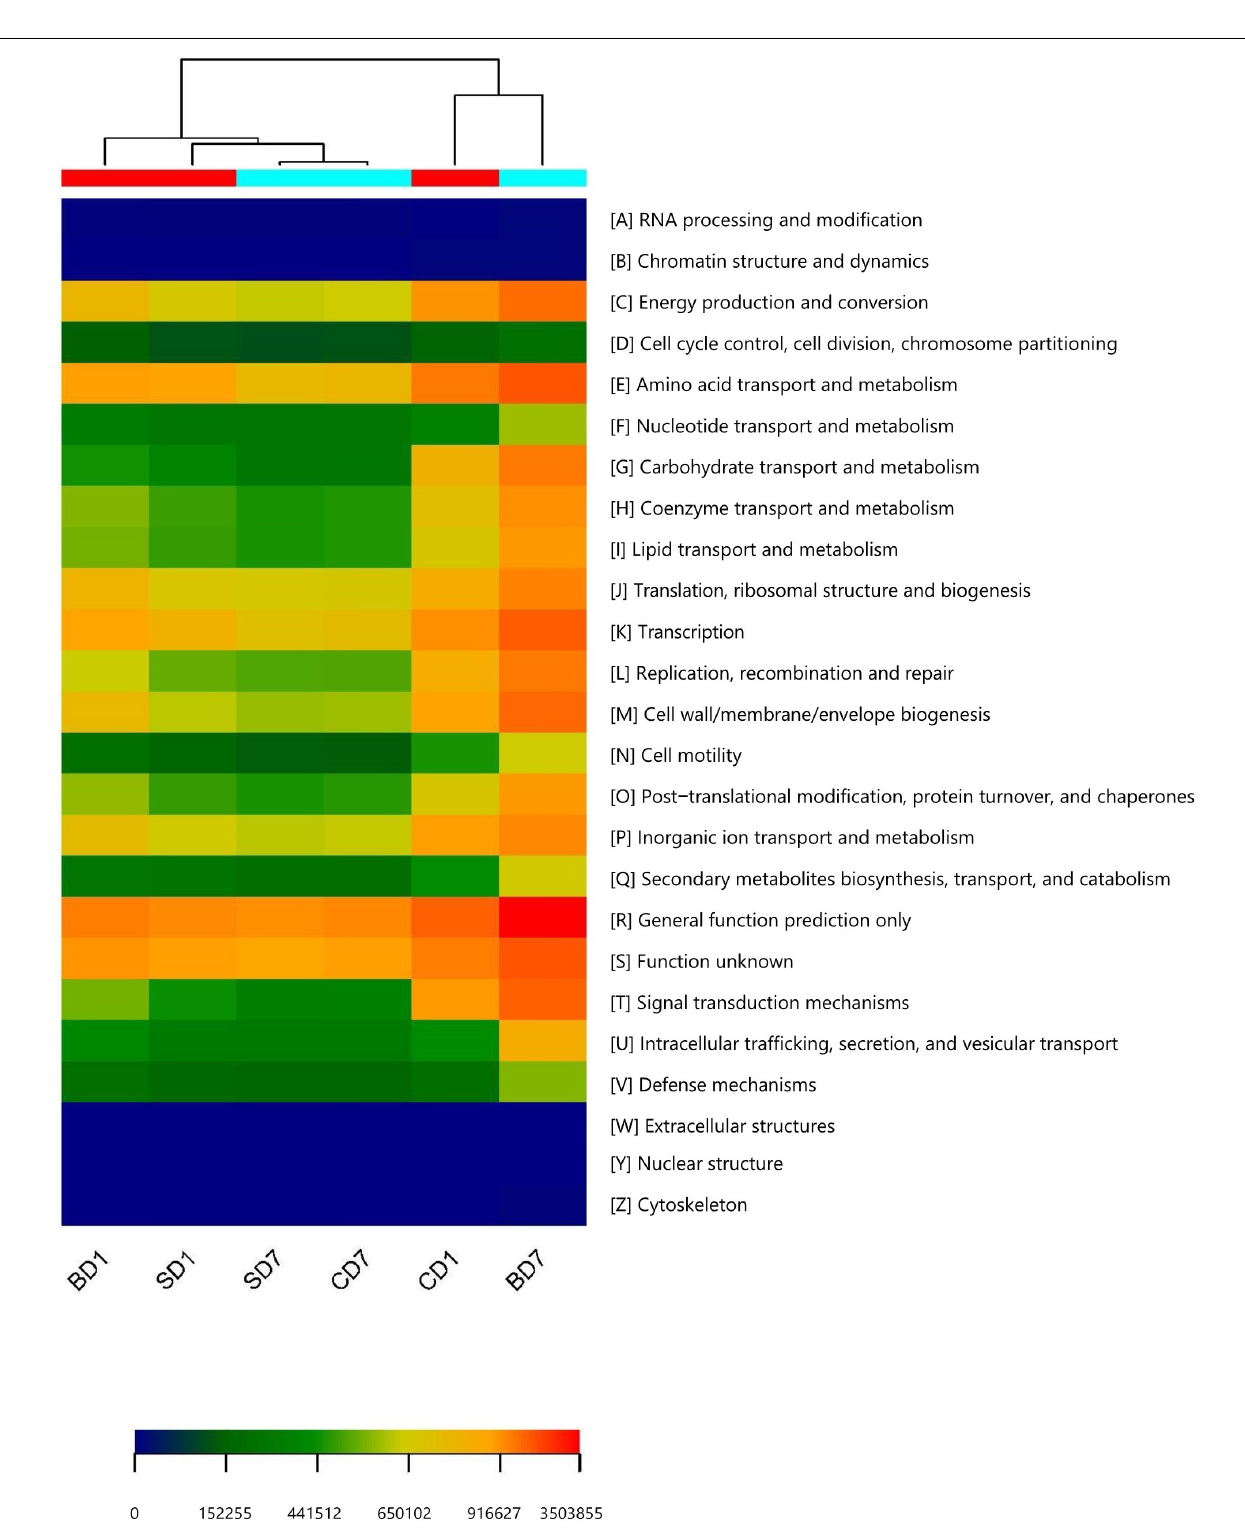
Frontiers in Microbiology |